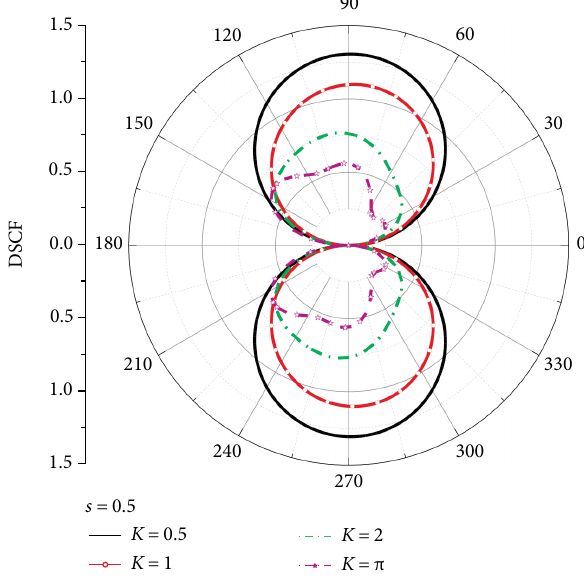
Figure 9: Distributions of DSCF around a circular hole with various 5 𝐾 for 𝑠 = 0.